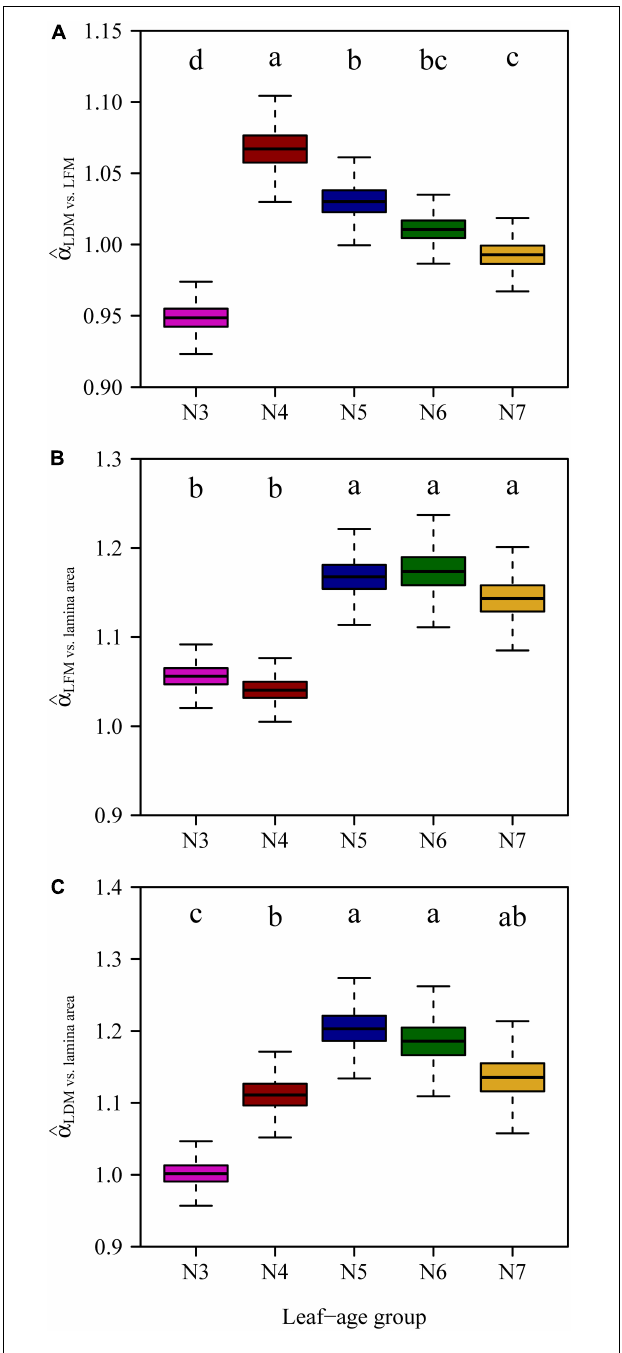
FIGURE 6 | Comparisons of the scaling exponents of LDM vs. LFM (A) , LFM vs. lamina area (B) , LDM vs. lamina area (C) for the five leaf-age groups. The lowercase letters indicate the significance of the difference between any two of the five leaf-age